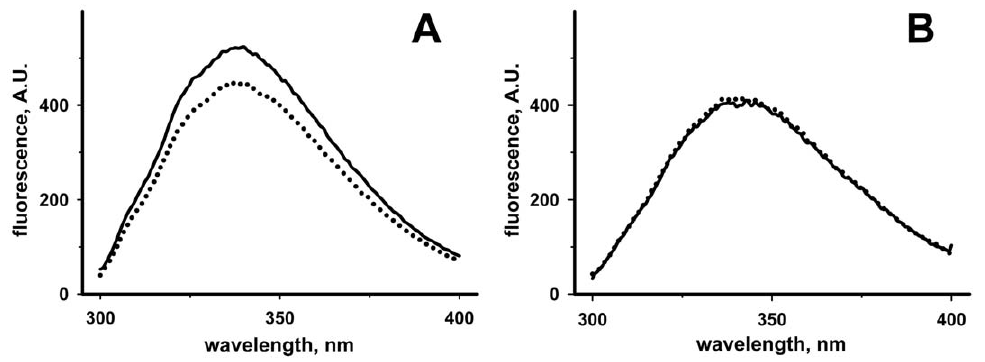
Figure 4. Intrinsic fluorescence changes of RhdA and RhdA-Cys 230 Ala in the presence of GSH. Tryptophan fluorescence emission spectra ( l ex =280 nm; dotted lines) of RhdA ( A ) and RhdA-Cys 230 Ala ( B ) in the presence of 50 m M GSH. Solid lines report spectra before the addition of GSH. Both RhdA and RhdA-Cys 230 Ala were 2 m M in 50 mM Tris-HCl, 100 mM NaCl (pH 7.4). Spectra were corrected for